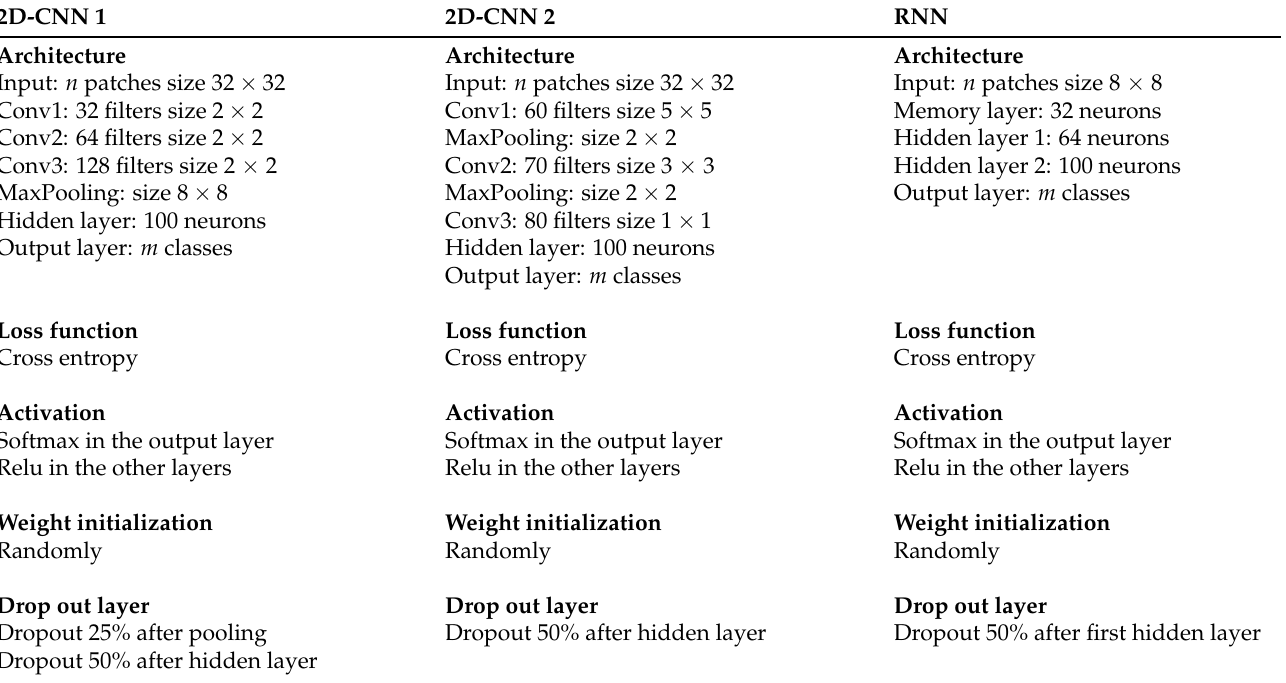
Table 2. DL architectures